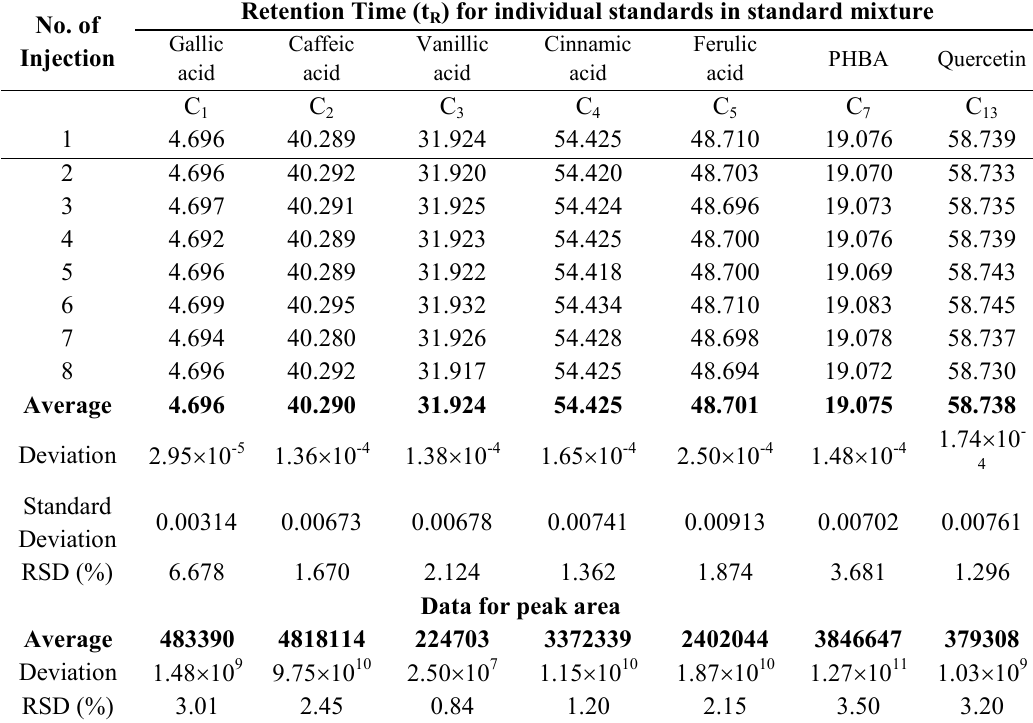
Table 2. Retention time, Deviation, Standard deviation and percentage RSD for Individual standards in the mixture of eight